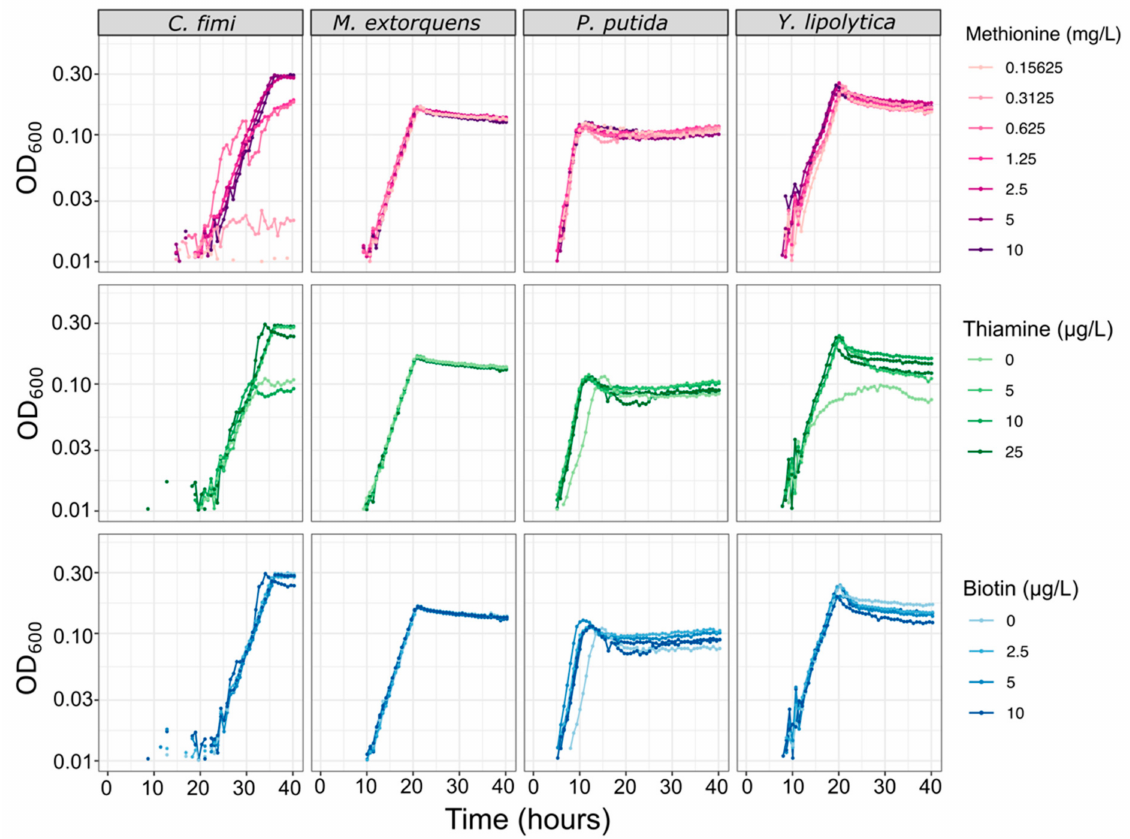
Figure 5. Vitamin and amino acid supplements have minimal effect on growth rates of each of the consortium members, except for C. fimi. Each species was grown in pure culture in minimal medium with a range of concentrations of methionine, thiamine, or biotin. For the methionine experiment, all cultures contained 25 µ g/L thiamine and 10 µ g/L biotin; for the thiamine experiment, 10 mg/L methionine and 10 µ g/L biotin; for the biotin experiment, 10 mg/L methionine and 25 µ g/L